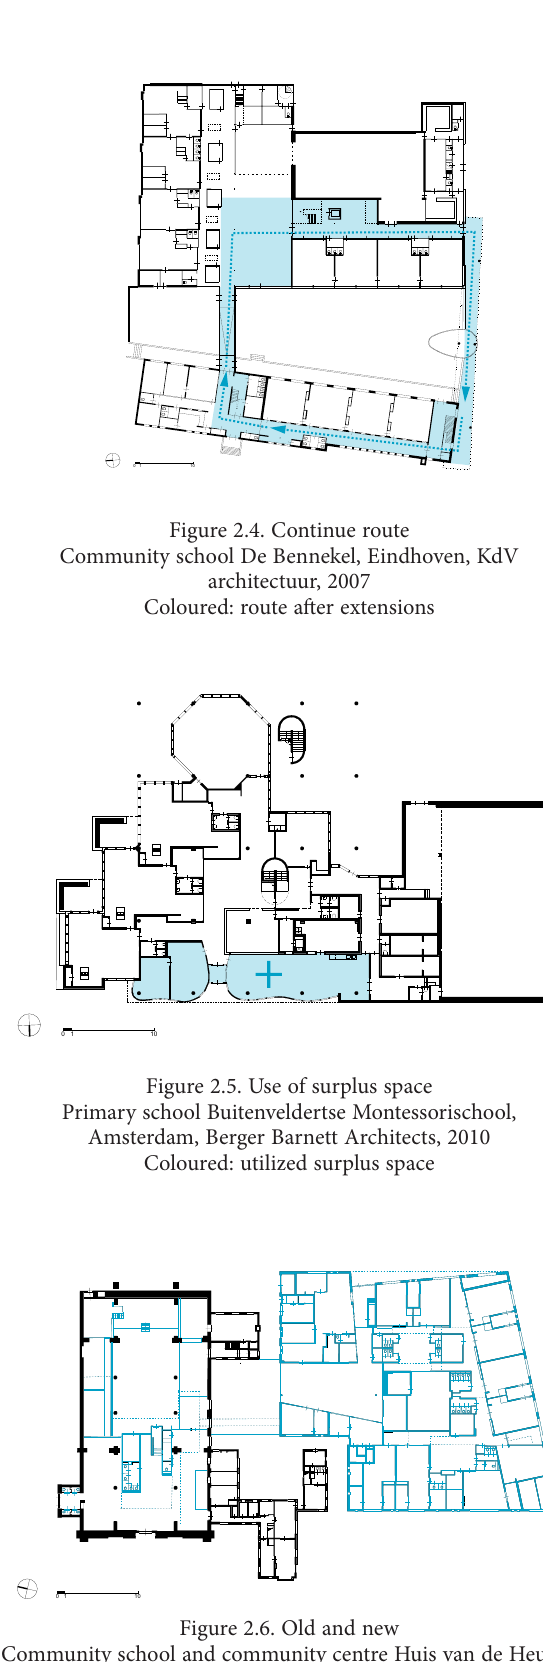
Figure 2.3. Restore original qualities